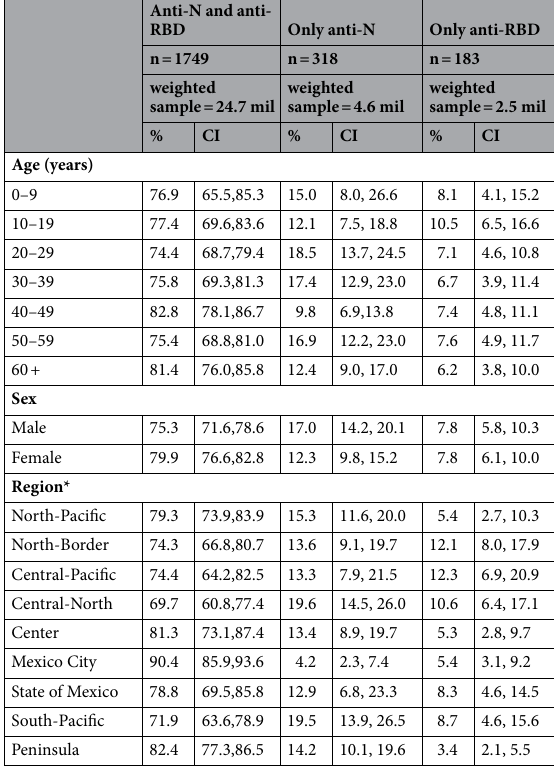
Table 3. Distribution of double-positive (anti-N and anti-RBD), only positive to anti-N, and only positive to anti-RBD by age, sex, region, and symptoms. Ensanut-Covid19, 2020, Mexico. *North-Border: Chihuahua, Coahuila, Nuevo León, Tamaulipas; Central-Pacific: Colima, Jalisco, Michoacán; Central-North: Aguascalientes, Durango, Guanajuato, Querétaro, San Luis Potosí, Zacatecas; Center: Hidalgo, Tlaxcala, Veracruz; North-Pacific: Baja California, Baja California Sur, Nayarit, Sinaloa, Sonora; South-Pacific: Guerrero, Morelos, Oaxaca, Puebla; and Peninsula: Campeche, Chiapas, Quintana Roo, Tabasco,